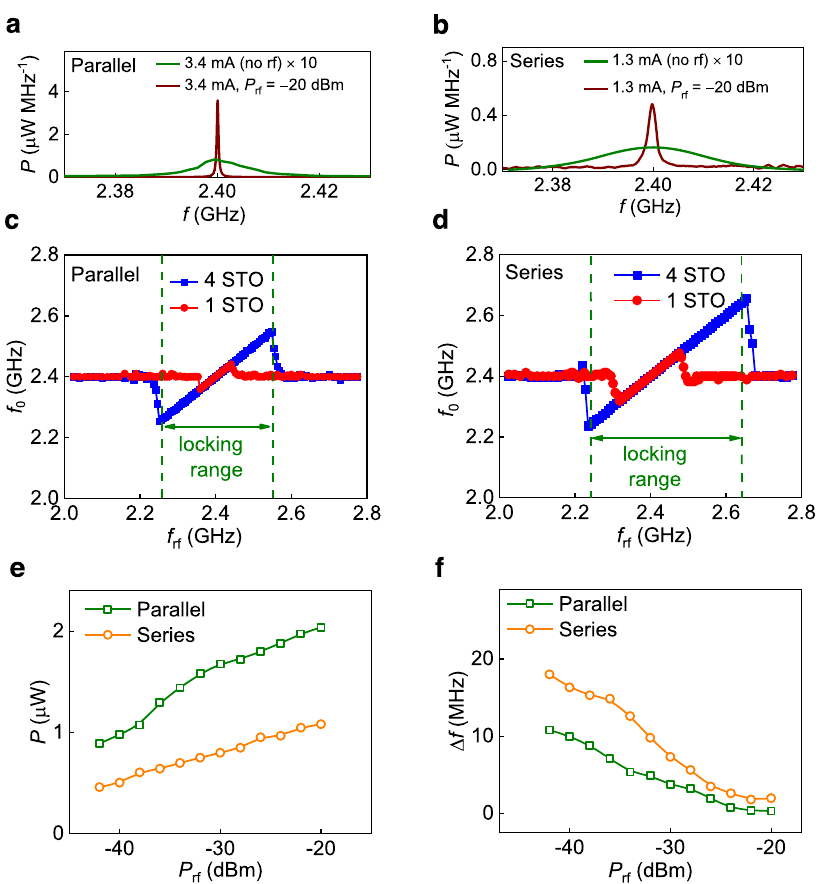
Fig. 3 Synchronization with injection locking at 2.4 GHz. a , b Emitted power spectra of four synchronized oscillators with dc bias only (green) and with both dc bias and rf input (brown) in parallel ( a ) (series ( b )) con fi guration at I dc = 3.4 mA (1.3 mA) and H = 150 Oe (120 Oe), respectively. c , d STO frequency ( f 0 ) versus radio frequency ( f rf ) response for a single oscillator (red) and four oscillators (blue) at P rf = − 20 dBm for the parallel ( c ) and series ( d ) connection. The locking range (dotted green line) de fi nes the region where f 0 ~ f rf . e , f The emitted power and linewidth of synchronized oscillators as a function of applied rf power ( P rf ) at I dc = 3.4 (1.3 mA) for the parallel (series) con fi guration, con fi guration and from 0.4 to 1.08 µW (2.7 times) in the series con fi guration compared to the synchronization with the dc bias only ( I rf = 0). The corresponding reduction in the linewidth is from 8.4 to 0.35 MHz (24 times) in the parallel con fi guration and from 18 to 1.8 MHz (10 times) in the series con fi guration. In oscillators improve the power and linewidth from 0.14 to 2.12 µW (15 times) and from 28 to 0.35 MHz (80 times), respectively, in the parallel con fi guration. For the series connection, the power is improved from 0.089 to 1.08 µW (12 times), and linewidth